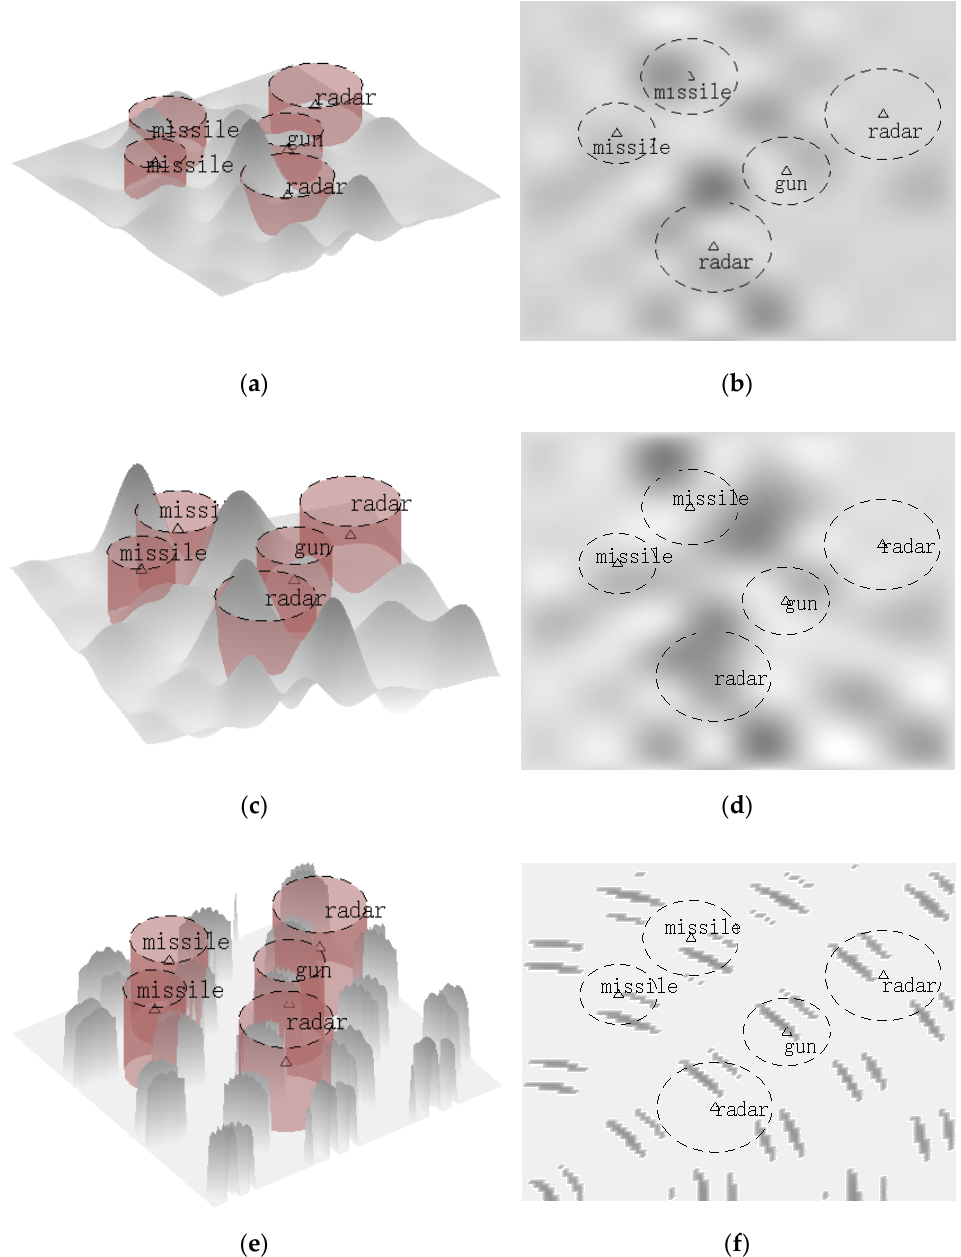
Figure 1. ( a , c , e ) are the three-dimensional (3D) displays of the three simulation scenarios, which show the terrain and threat sources in the mission map; ( b , d , f ) are the corresponding 2D views of the simulation scenarios.